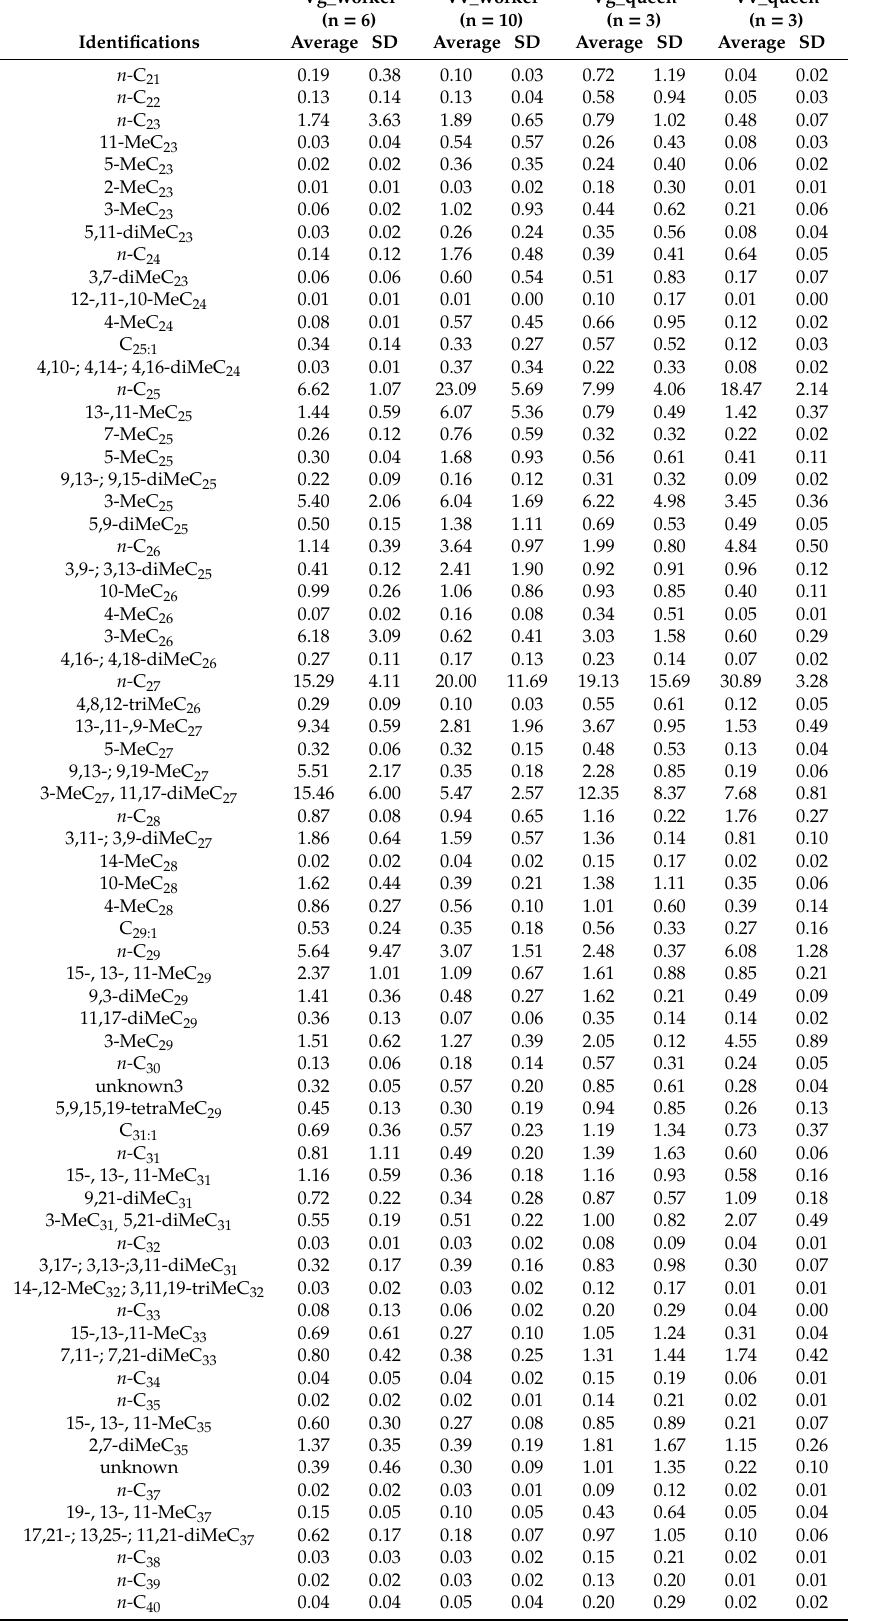
Table 2. List of hydrocarbons of the hosts Vespula vulgaris and Vespula germanica and their relative amounts (n = number of